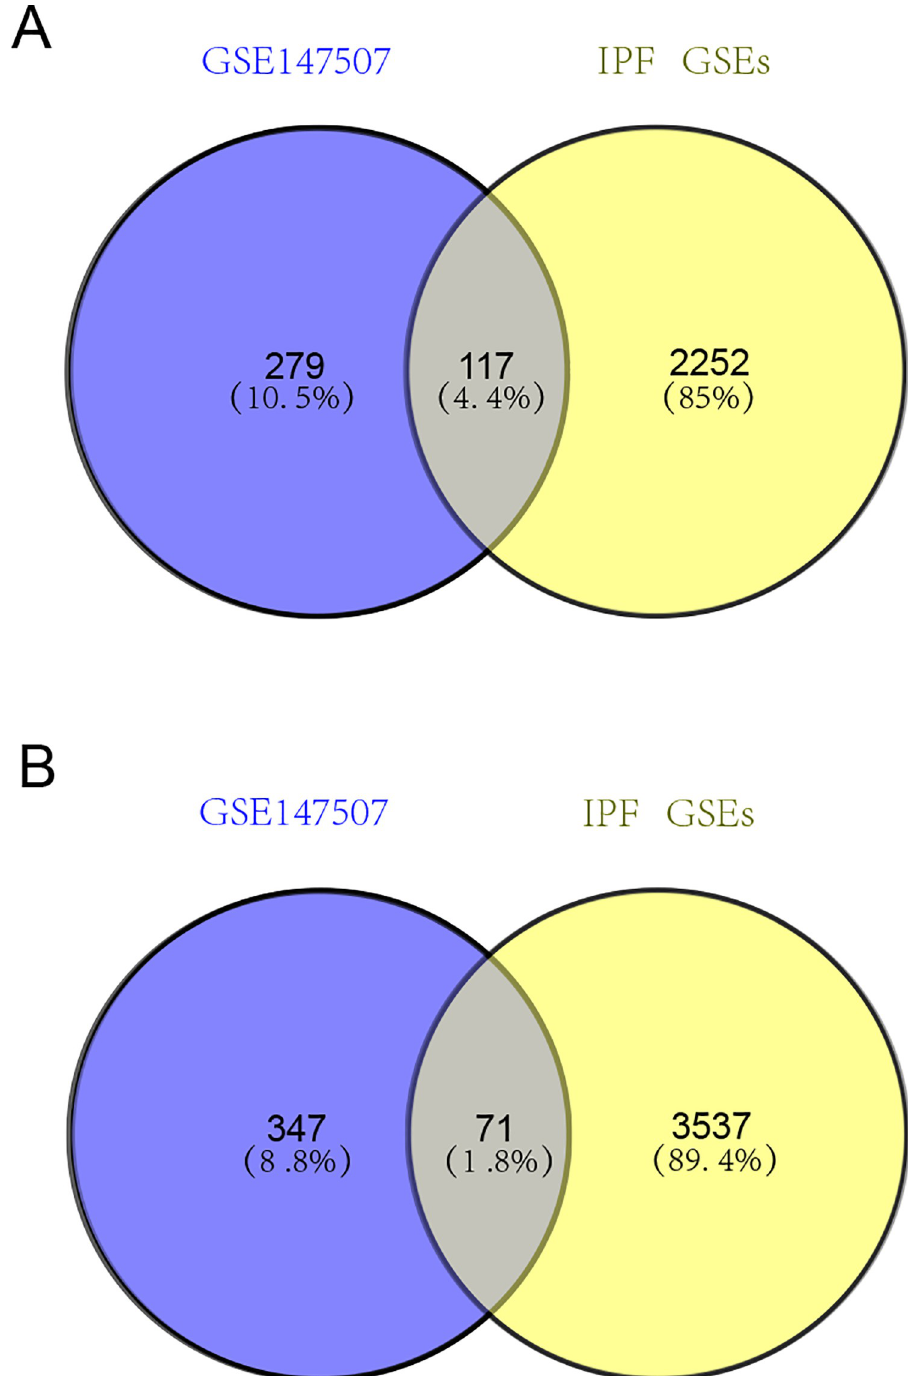
Fig 3. Venn diagram showing differentially expressed genes between COVID-19 and IPF. A: Upregulated DEGs between COVID-19 and IPF. B: Downregulated DEGs between COVID-19 and IPF. The blue circle in Venn diagram represents DEGs in COVID-19 dataset, and yellow circle represents five DEGs in IPF datasets.